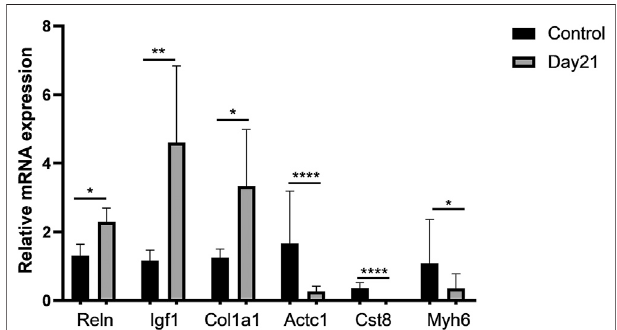
FIGURE 5 | Validation of representative genes in differentially expressed pathways. A total of six differentially expressed genes (DEGs) involving three upregulated DEGs, Reln, Igf1, and Col1a1, and three downregulated DEGs, Actc1, Cst8, and Myh6, were validated by qRT-PCR. Total RNA of mouse lung tissue was extracted using TRIzol, and then qRT-PCR was performed after cDNA was constructed. Every sample was performed three times in triplicate. Each error bar indicates the mean ± SD of eight mice per group. * p < 0.05, ** p < 0.01, **** p <